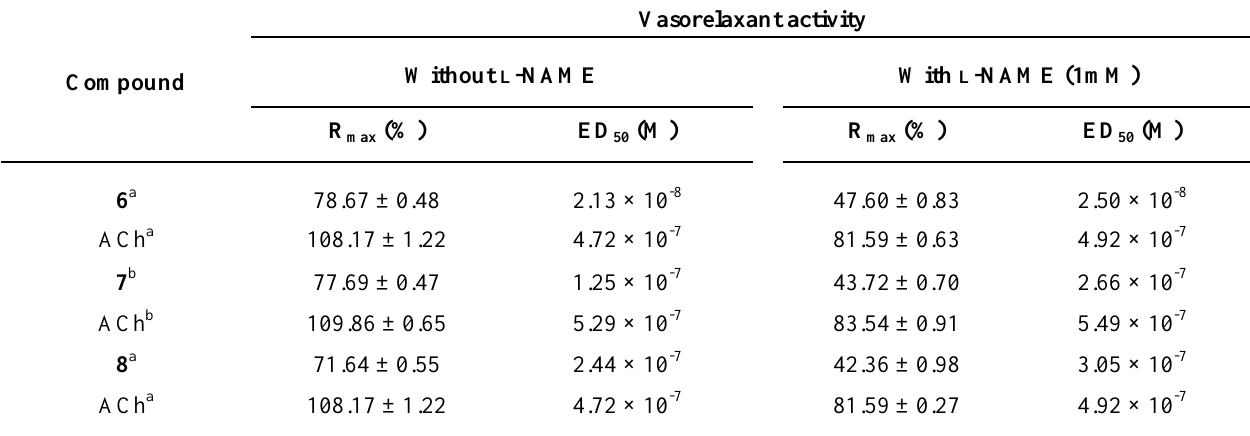
Table 1. Vasorelaxant activity of thionicotinic acid analogs 6 - 8